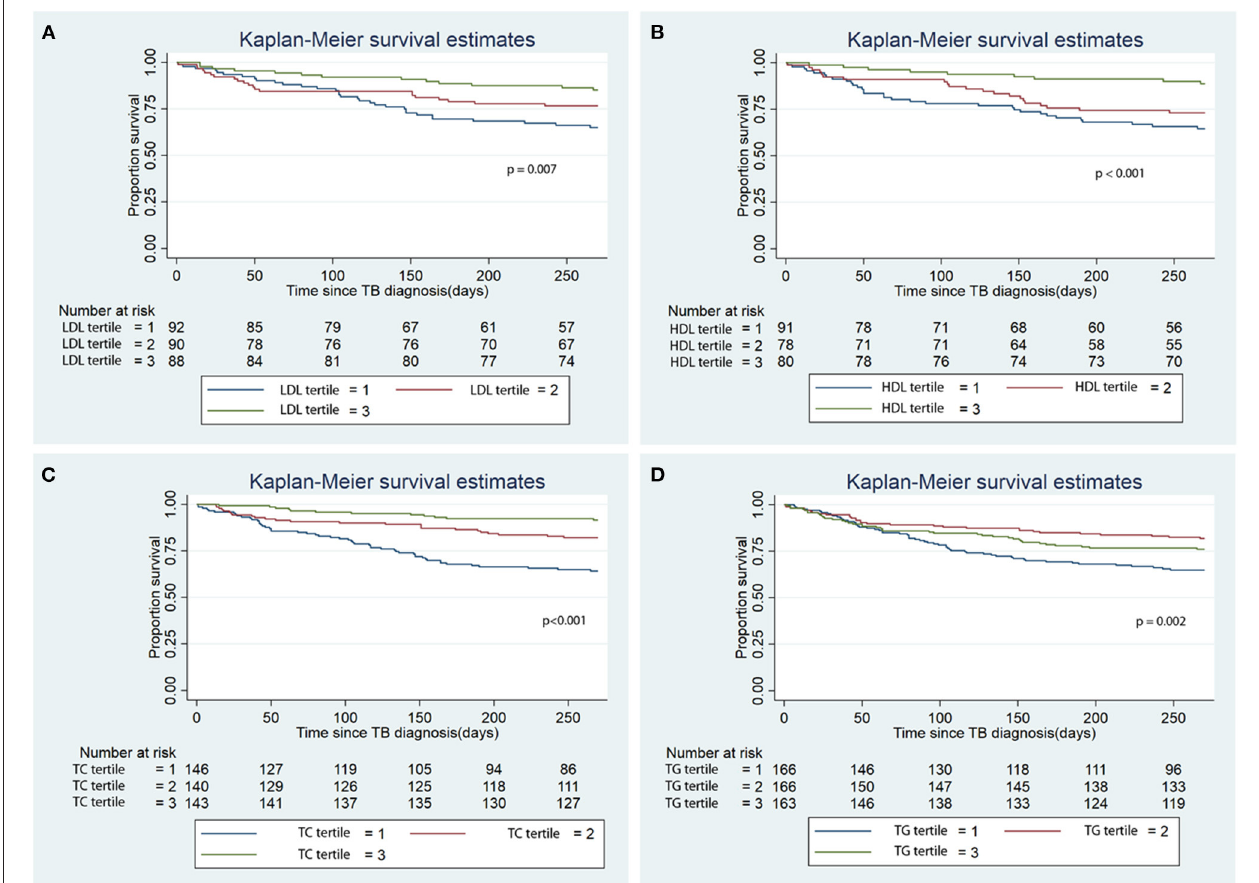
FIGURE 2 | Kaplan Meier analysis of the association of baseline serum lipid level tertile with all-cause mortality. (A) Low density lipoprotein (LDL); (B) High density lipoprotein (HDL); (C) Total cholesterol (TC); (D) Triglycerides (TG). TB, tuberculosis. of diabetes mellitus in the lowest tertiles of TC (12.2 vs. 35.7 vs. 27.9%, p -value = 0.025) and TG (18.7 vs. 28.3 vs. 35.6%, p -value = 0.003) ( Tables 1 , 2 ). Inflammatory markers, namely CRP,